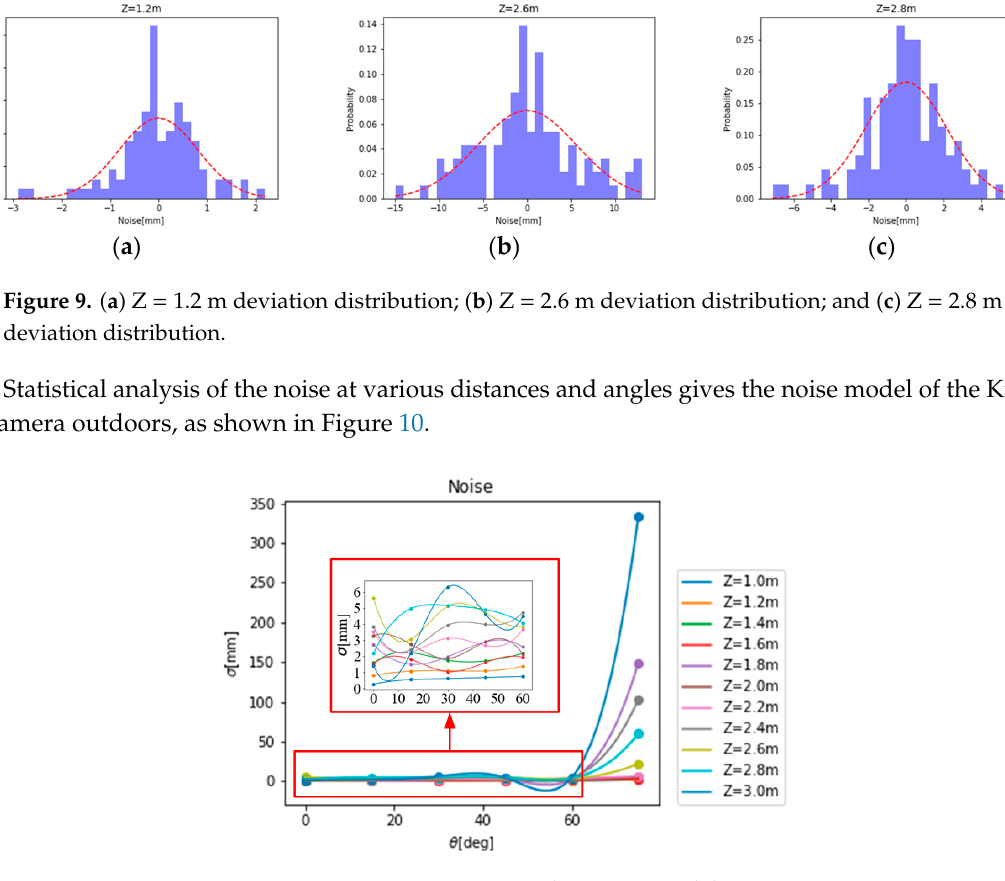
Figure 10. Kinect V1.0 outdoor noise model.